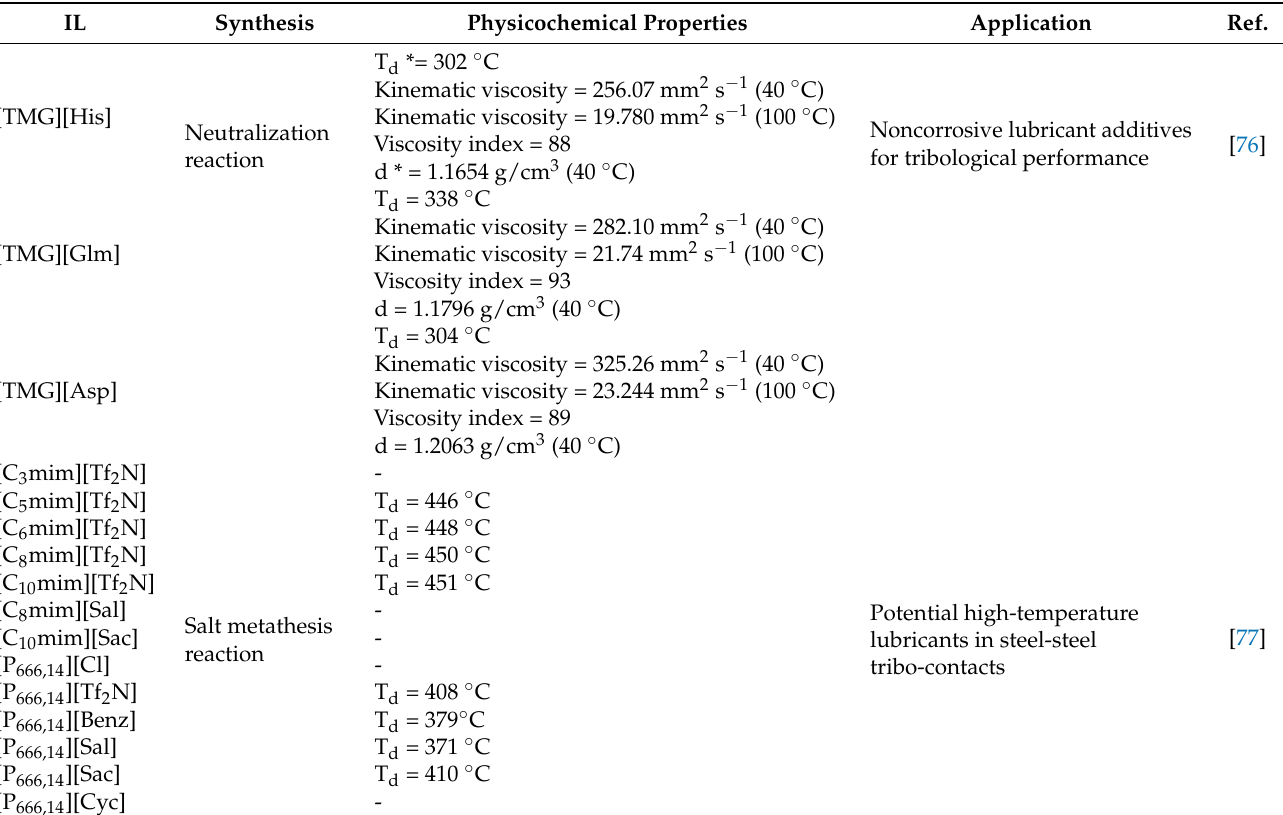
Table 5. Overview of recently investigated Bio-ILs as lubricants.